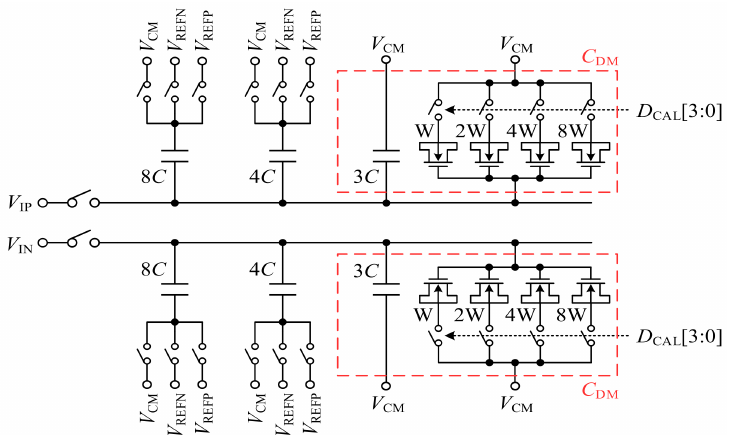
Figure 3. Capacitive